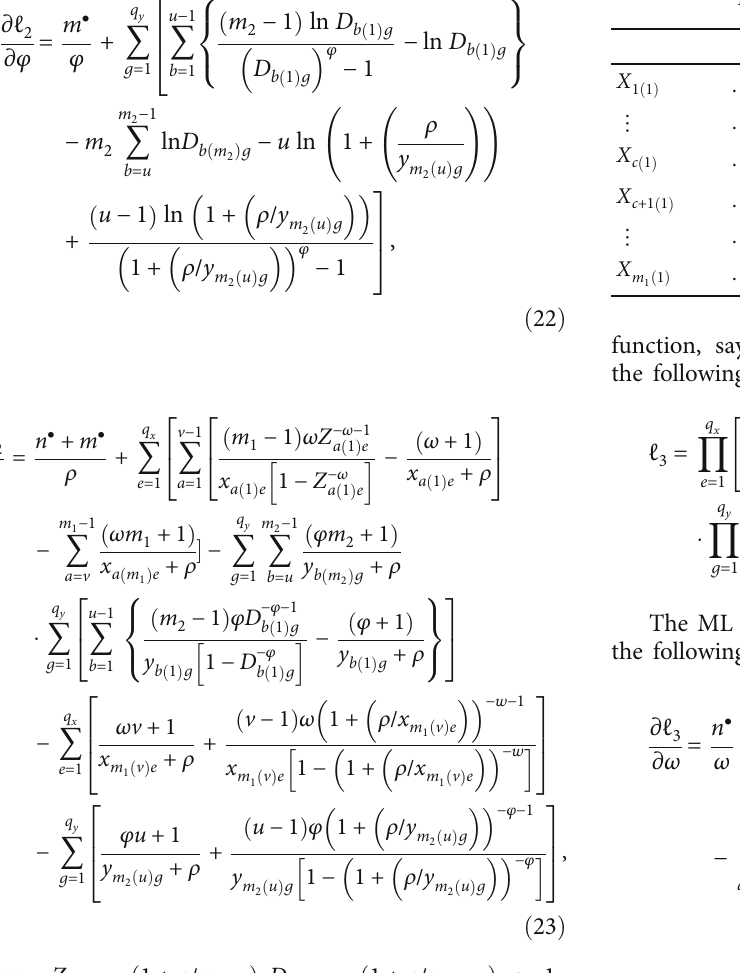
Table 2: The observed ERSS with